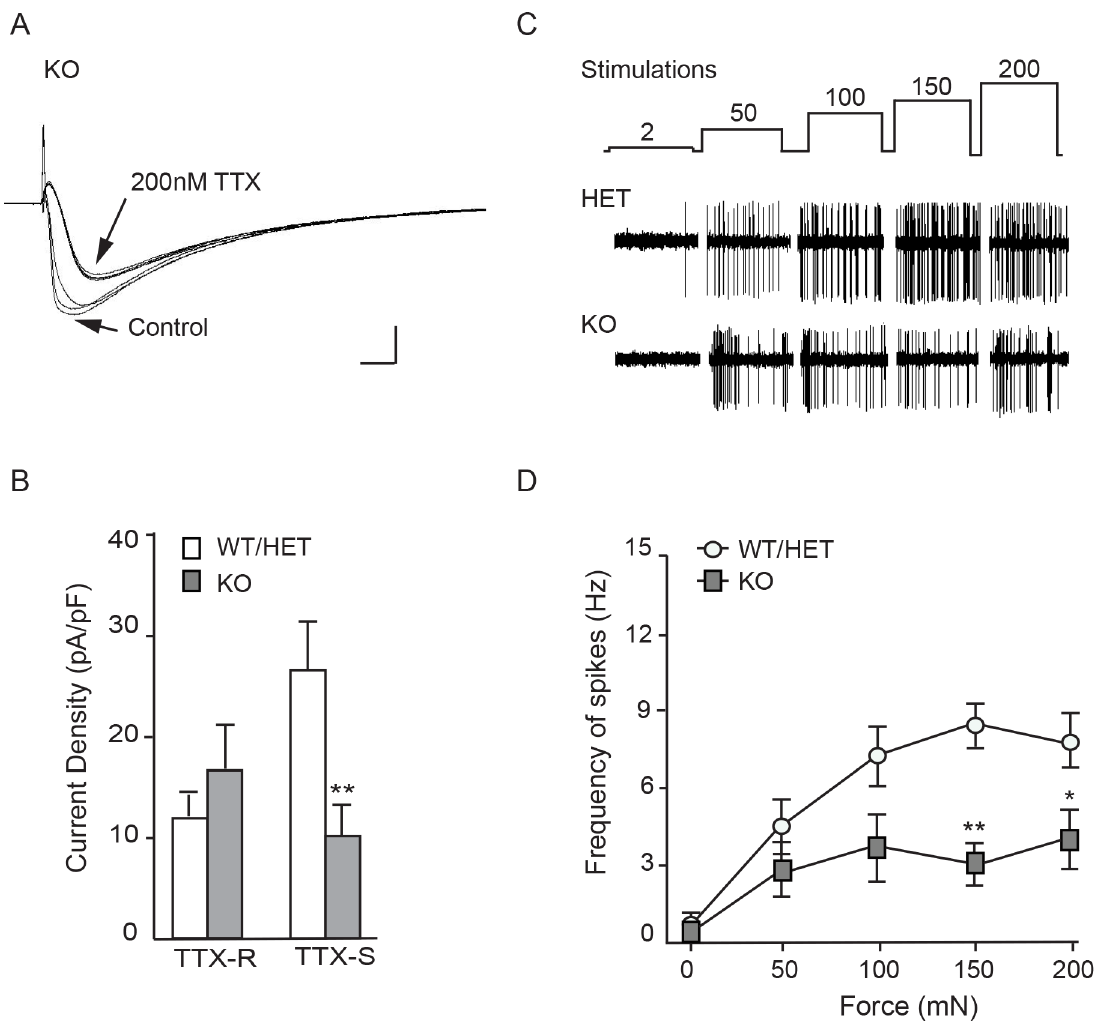
Figure 6. TTX-sensitive currents and mechanically-evoked spiking of C-fibers are reduced in KO mice. A. Representative current traces showing the effect of 200 nM TTX on a KO DRG neuron. Overlaid sweeps show the time course of selective TTX blockade of fast-inactivating currents. Sweeps shown are the three before and the three after TTX addition (inter-sweep interval 10 s). Scale bars, 200 pA and 2 ms. B . Average current densities from acutely dissociated Nav1.7 KO and age-matched WT adult DRG neurons. TTX-S currents: 10.1 6 3.06 pA/pF, n=12 neurons from 2 KO animals; and WT/HET, 27.2 6 4.53 pA/pF, n=16 neurons from 4 control animals (2 WT and 2 HET) (p=0.0074, unpaired t-test, mean 6 S.E.M.). TTX-R currents: 16.9 6 4.44 pA/pF from KO, 11.9 6 3.26 from WT/HET (p=0.3638, unpaired t-test, mean 6 S.E.M.). Cell capacitance averaged 50.2 pF 6 5.7 pF from WT/HET and 65.4 pF 6 8.6 pF from KO (p=0.069, unpaired t-test, mean 6 S.E.M.). C . Representative mechanically-evoked action potentials in saphenous nerve. Upper trace shows the stimulation protocol (mN); middle and lower traces show representative action potentials from a single